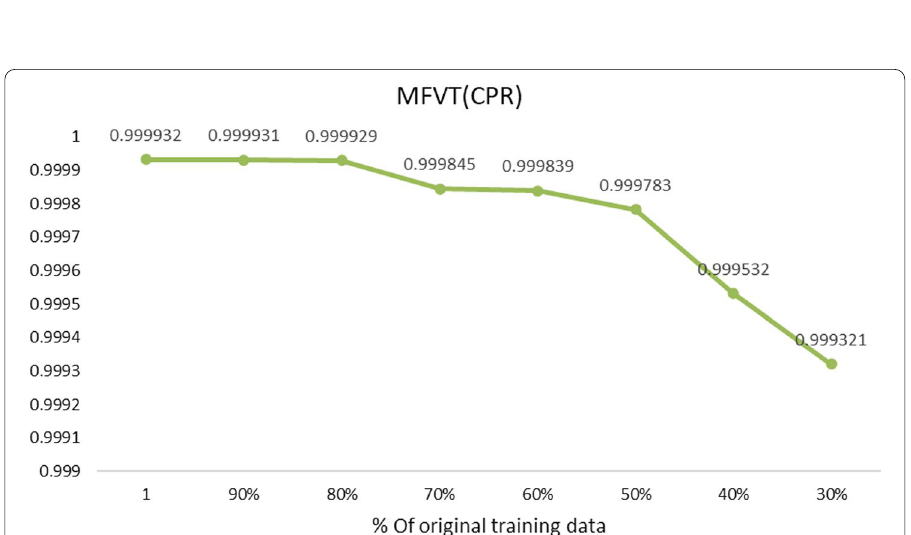
Fig. 10 Experimental results for different training set data